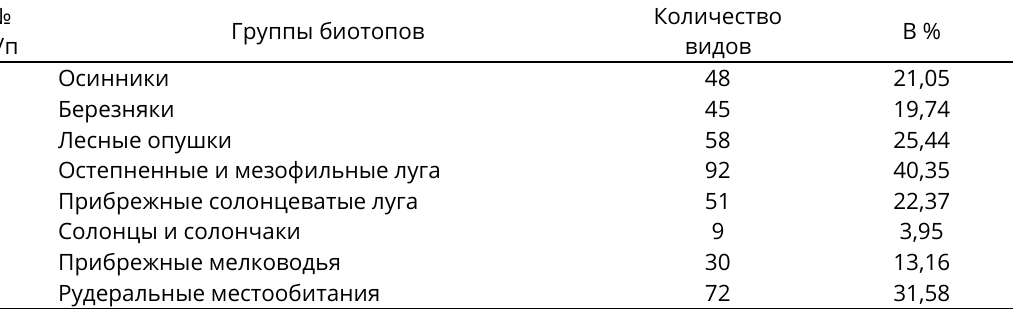
Table 2. The biotopic spectrum of the flora of vascular plants of the regional nature reserve «Tavolzhansky» №